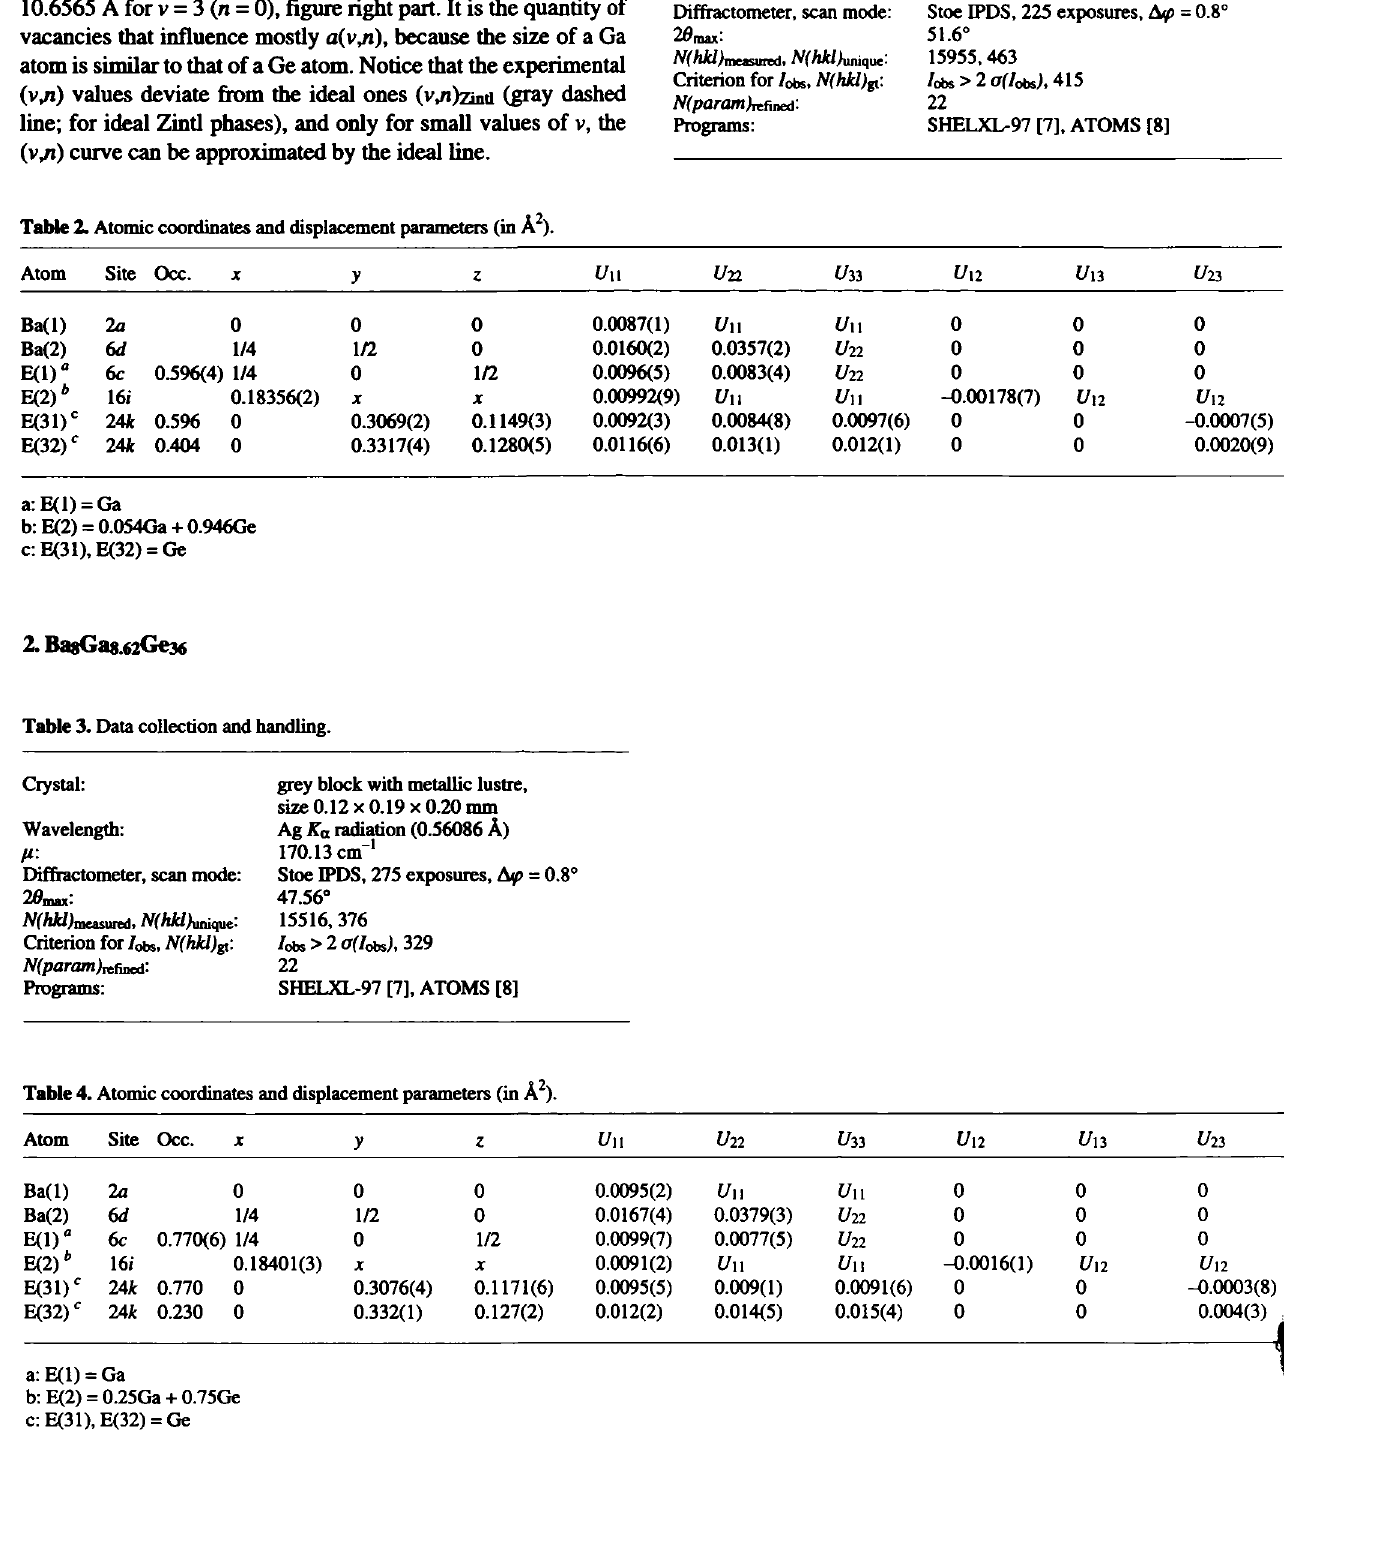
Table 2. Atomic coordinates and displacement parameters (in A 2 ).